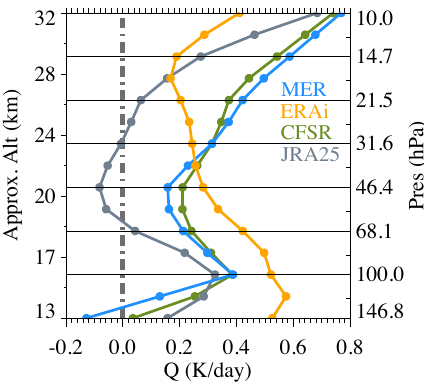
Figure 1. Comparison of total diabatic heating rates averaged over the deep tropics (18 ◦ N–18 ◦ S) in 2000–2010 from four different re- analysis data sets: MER (MERRA), ERAi (ECMWF ERA interim), CFSR (NCEP CFSR), and JRA25.